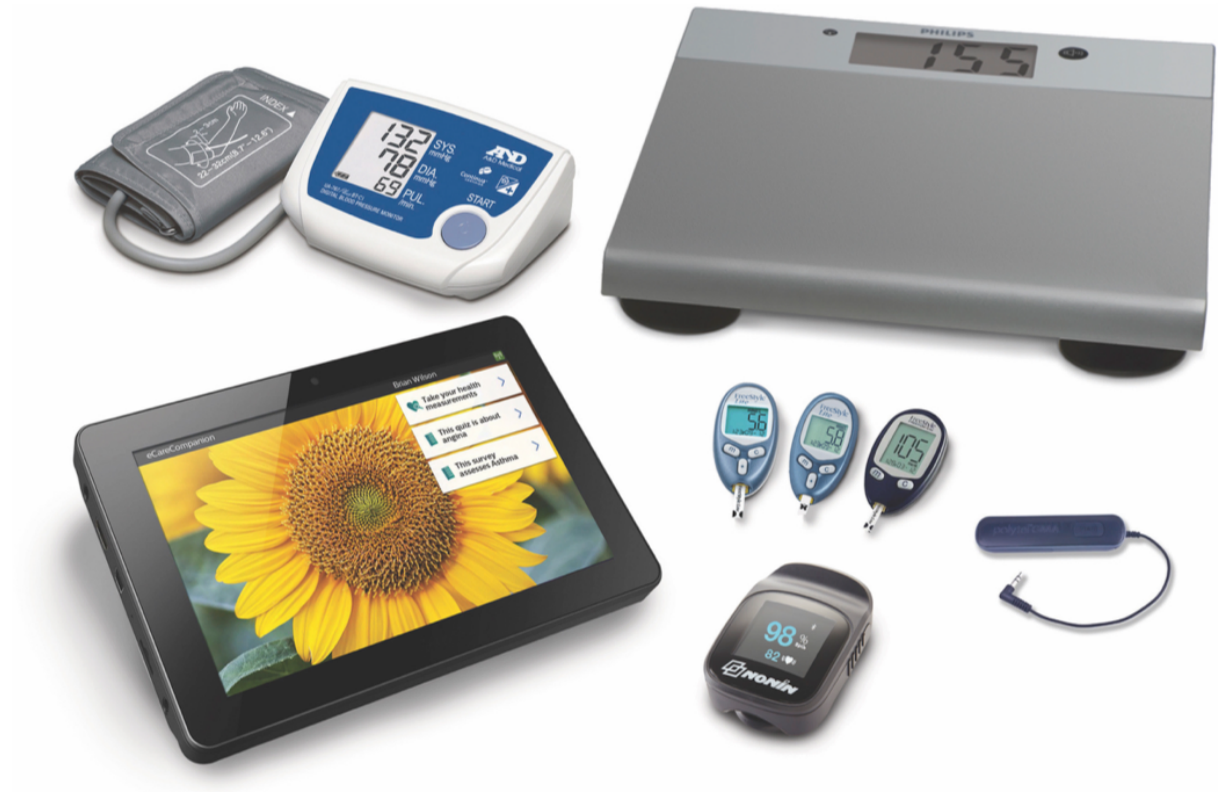
Figure 2. The Philips electronic Transition to Ambulatory Care system, featuring tablet interface and Bluetooth-enabled vital signs monitors. Reproduced with permission from Philips (reprinted with copyright permission from the